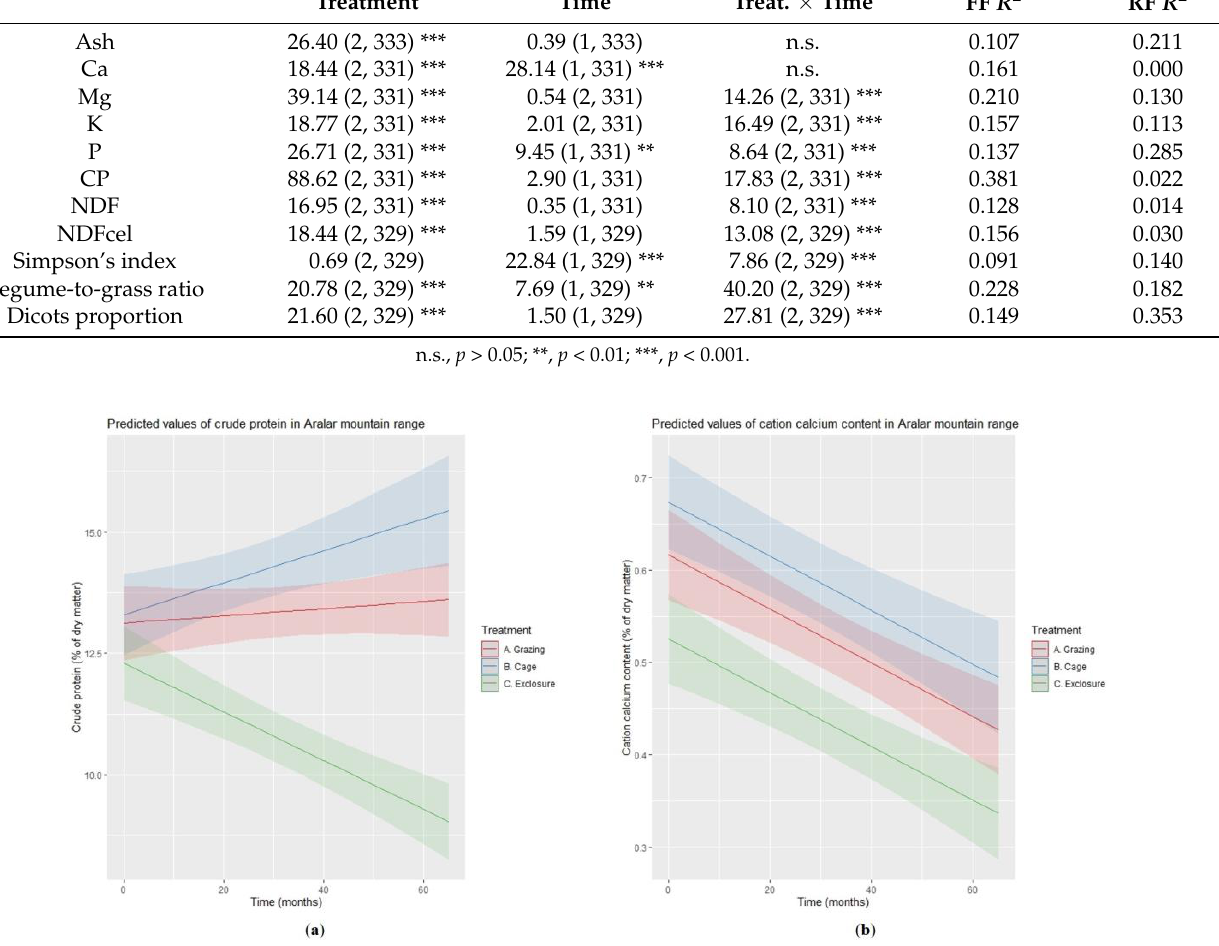
Figure 2. ( a ) Modeled change in crude protein; ( b ) Modeled change in cation calcium content. The patterns for the change in Mg, K, P and enzymatic digestibility are similar to that for crude protein, whereas the pattern for neutral detergent fiber is just the inverse of the pattern for enzymatic digestibility. Ash does not change over time (see Supplementary Figure S3). Time is indexed in months, starting in June 2005 (month number 1) and ending in October 2010 (month number 65). Restricted maximum likelihood estimates (ReML) for cation calcium content and crude protein at the end of each season (October) over the period 2005 – 2010 are presented in Supplementary Table S4.